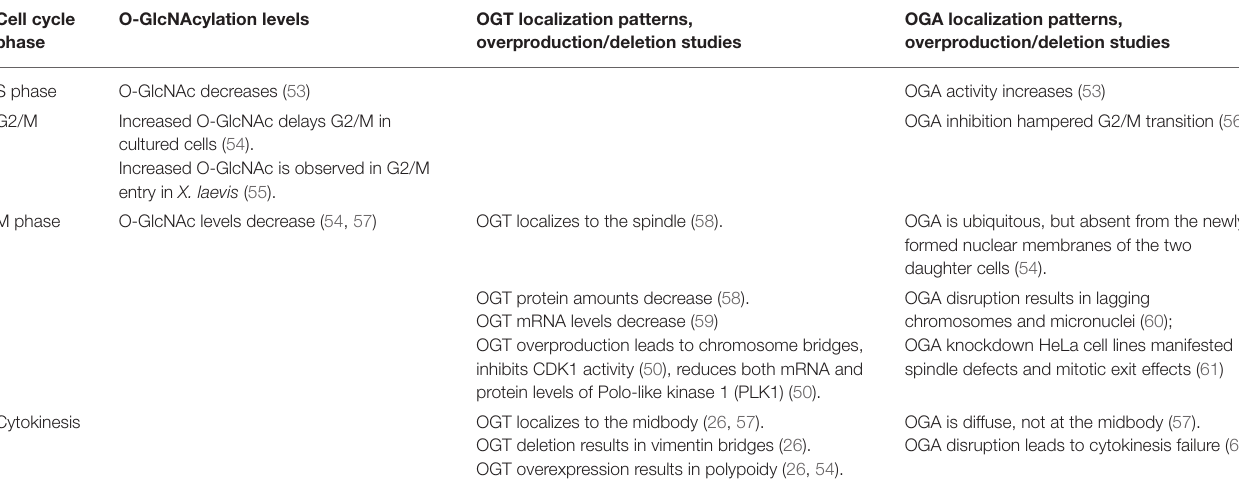
TABLE 1 | Effects of OGT and OGA on cell cycle progression.